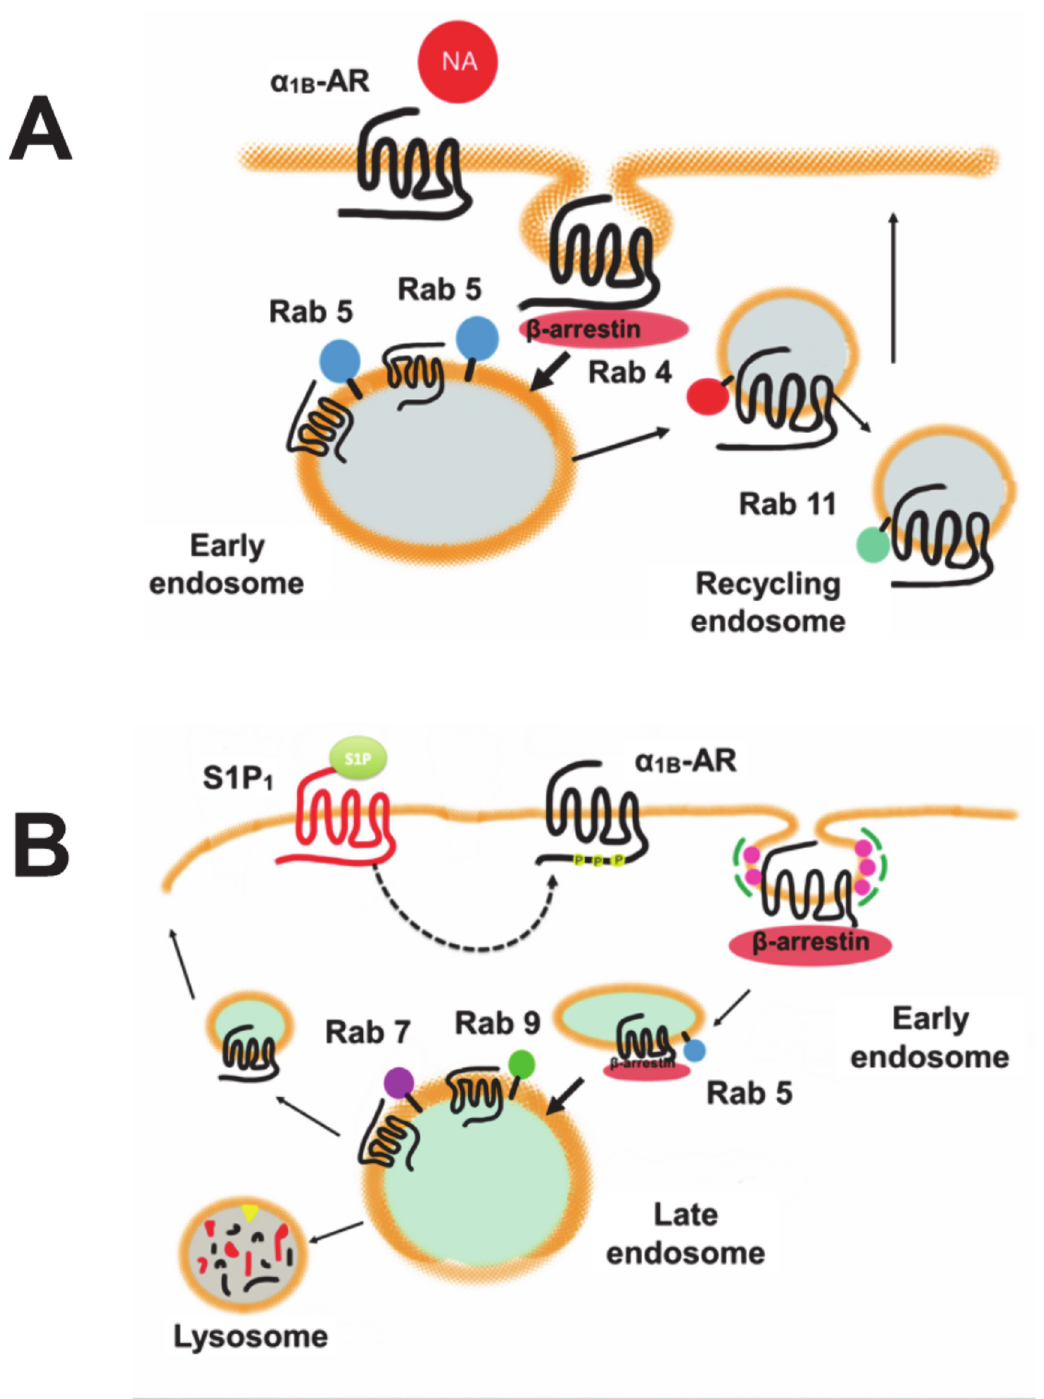
Fig 14. Models for α 1B -adrenergic-Rab protein interaction. α 1B -Adrenergic internalization and recycling back to the plasma membrane during homologous (panel A) and heterologous (panel B) desensitization is depicted. NA, noradrenaline; α 1B -AR, α 1B -adrenergic receptor; S1P, sphingosine 1-phosphate; S1P 1 , sphingosine 1-phosphate receptor type 1. Rab proteins are shown as membrane anchored proteins.